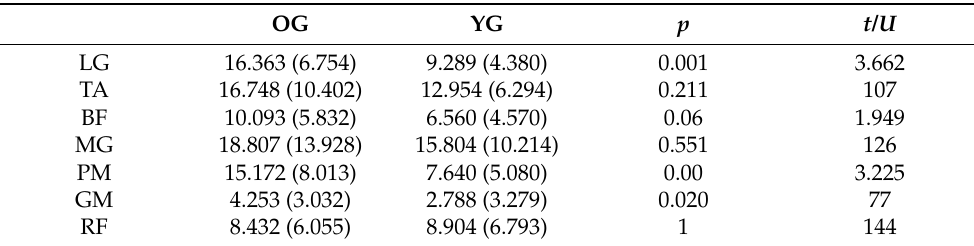
Table 3. The result of iEMG of CPAs (V). The first values represent group means while the values in the brackets stand for their standard